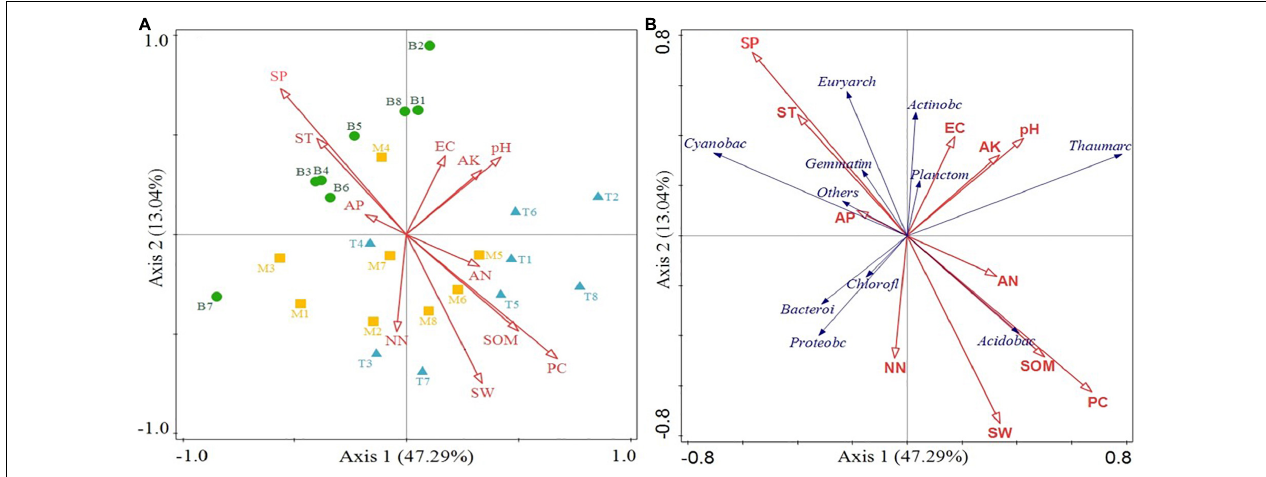
FIGURE 6 | Redundancy analysis (RDA) of samples and environmental factors (A) , environmental factors, and major phyla (B) .